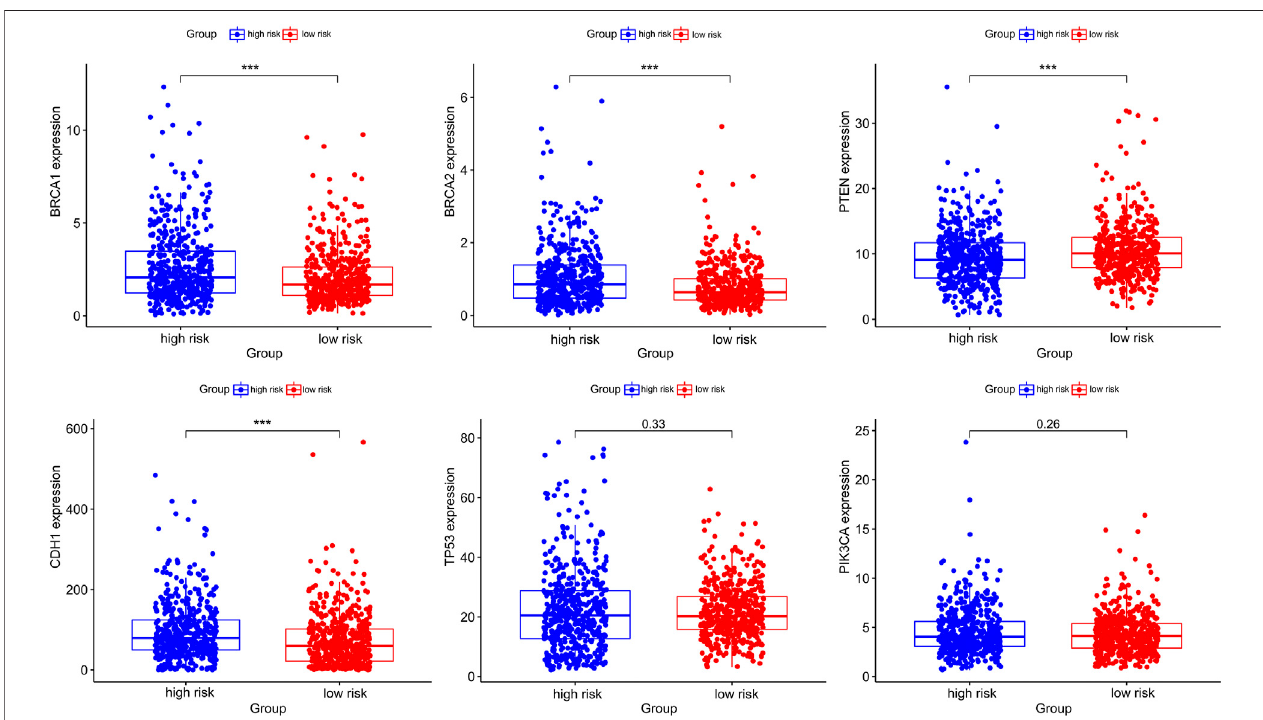
FIGURE 9 | The differential expression of breast cancer-associated genes in gene high-risk and low-risk groups.